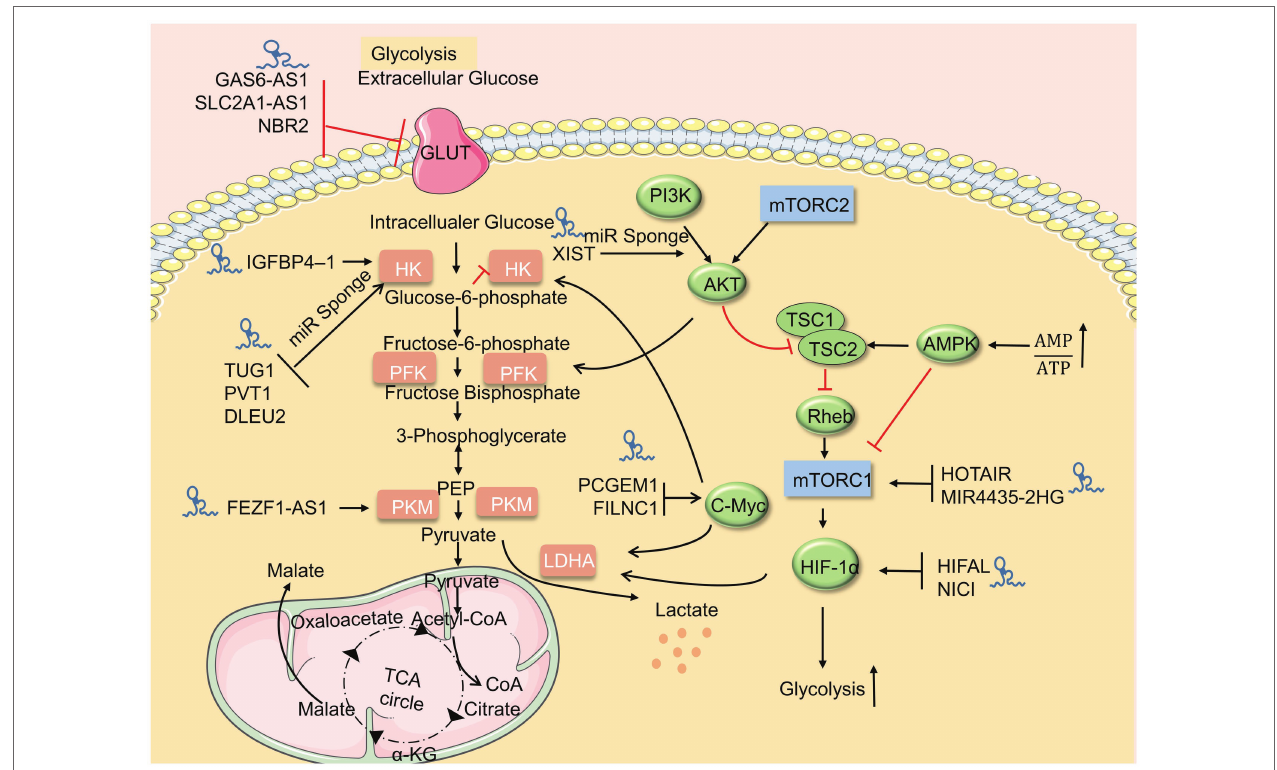
FIGURE 1 | LncRNAs regulate the glucose metabolism. Upstream metabolic pathways interact downstream glycolysis sites. Many lncRNAs regulate glycolysis via glycolysis sites, adenosine 5 ′ -monophosphate (AMP)-activated protein kinase (AMPK)/mammalian target of rapamycin (mTOR), and AKT/mTOR